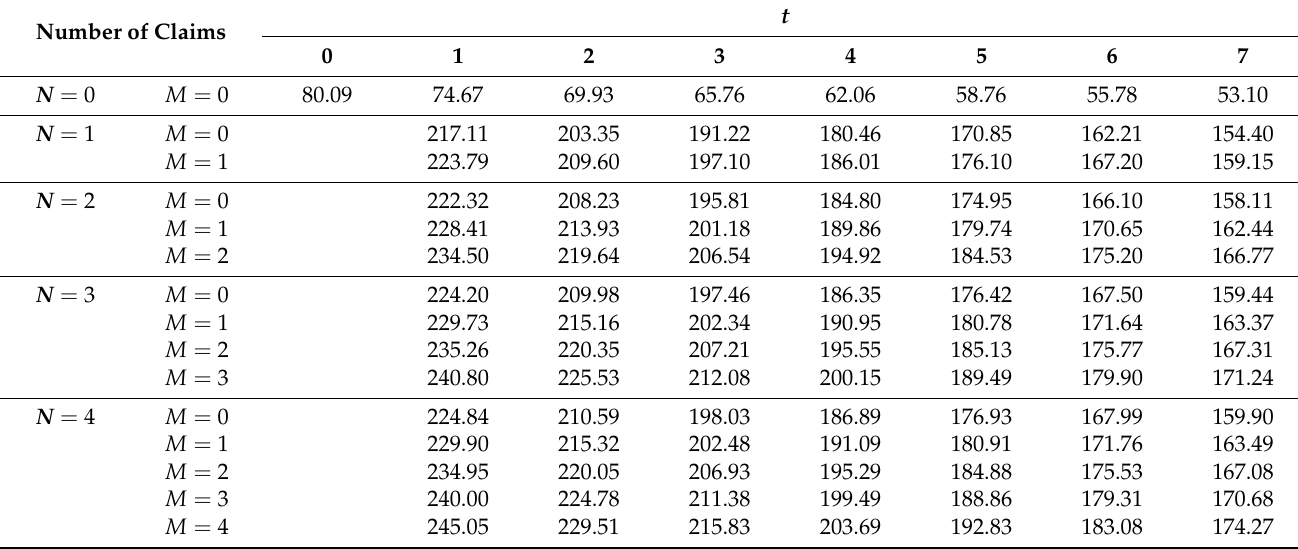
Table 10. Bonus-malus premiums based on Poisson binomial-exponential beta distribution for the frequency component and gamma-Lindley distribution for the severity component with a total claim size of S =